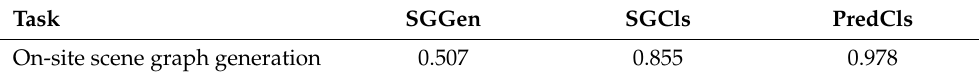
Table 6. Results of scene graph generation using the ResNeXt-101-FPN backbone. Task SGGen On-site scene graph